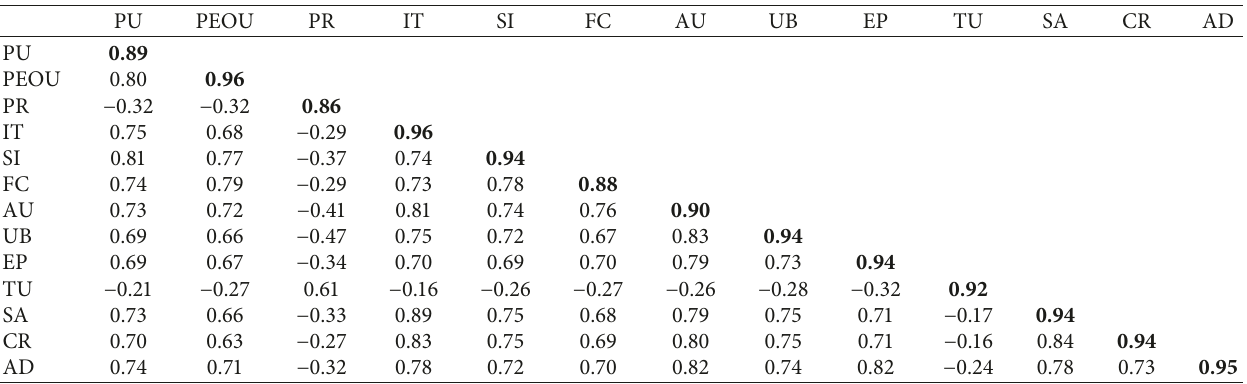
Table 6: Discriminant validity of the constructs.